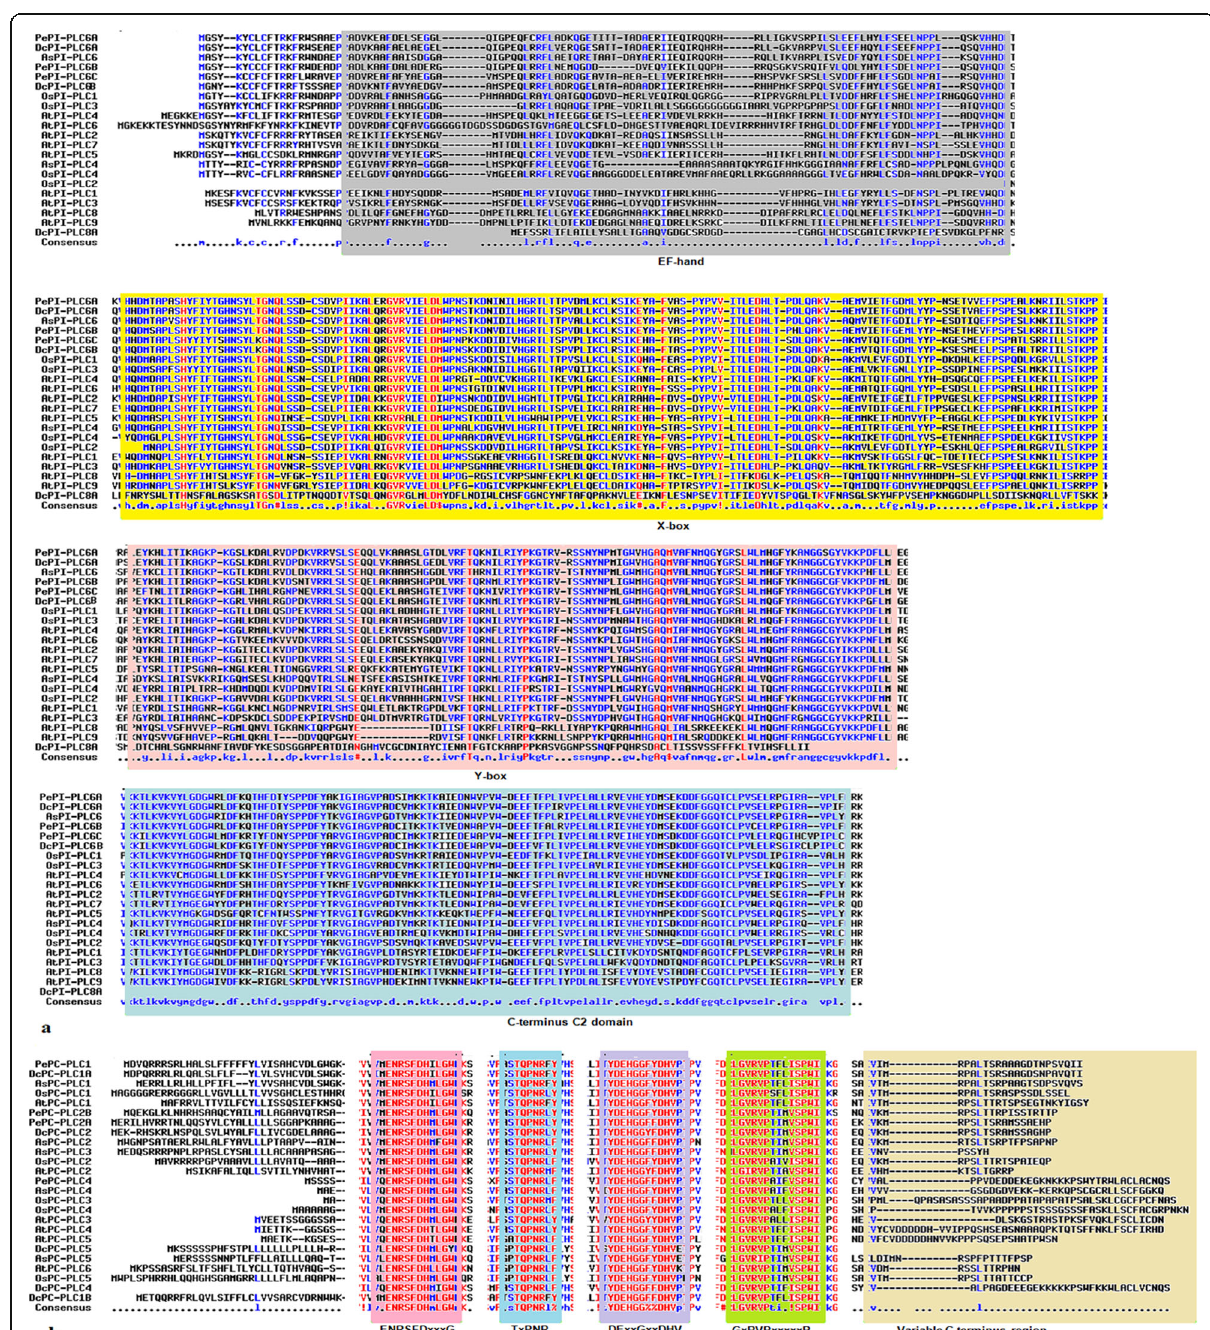
Fig. 2 Multiple sequence alignment. Multiple sequence alignment of PLC protein sequences of P. equestris , D. catenatum , A. shenzhenica , A. thaliana , and O. sativa with the Multalin online tool. Highly conserved amino acid sequence regions are highlighted with boxes for both PI-PLC ( a ) and PC-PLC ( b )